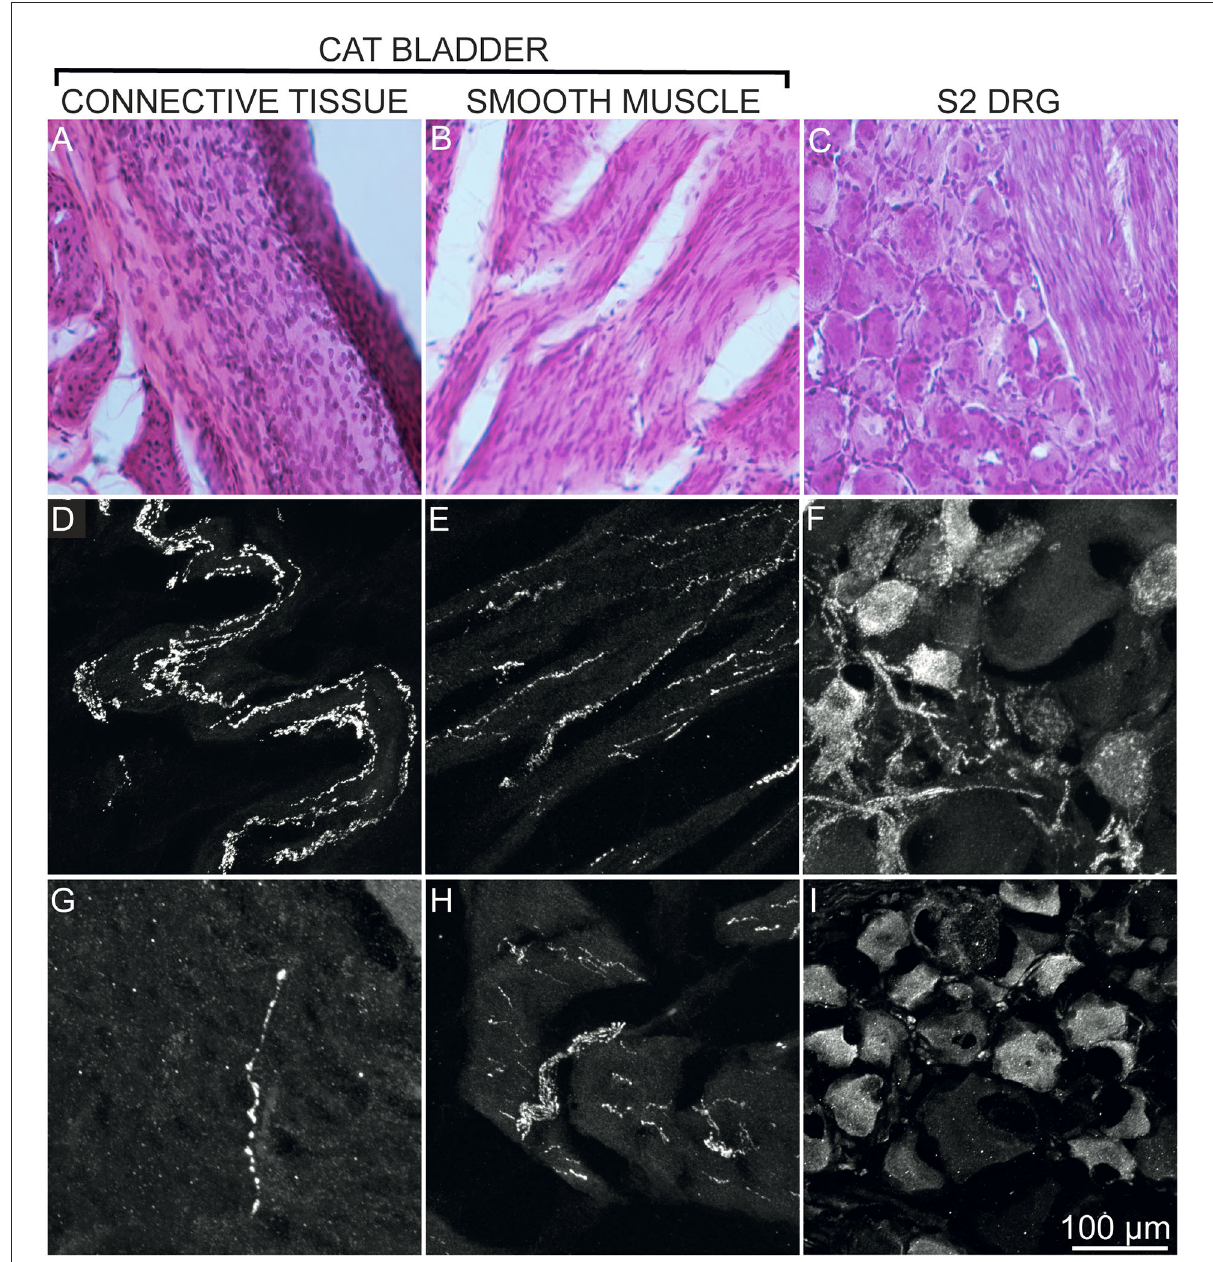
FIGURE1 Expression of CGRP and SP by axons innervating the cat bladder (connective tissue A, D, G ; smooth muscle B, E, H ) and by cell bodies of S2 DRG (C, F, I) of 2 healthy adult sexually intact female cats (pilot study). Images of hematoxylin and eosin-stained sections are shown to illustrate the regions used for confocal images (A–C) . Confocal images revealed an apparent more abundant presence of CGRP immunoreactive axons (D, E) and immunoreactive cell bodies (F) as compared to SP expression (G–I) . Confocal images were obtained at 40 × magnification using a Carl Zeiss scanning confocal laser microscope with Z-stack function. All panels represent tissues harvested from a healthy untreated cat (pilot